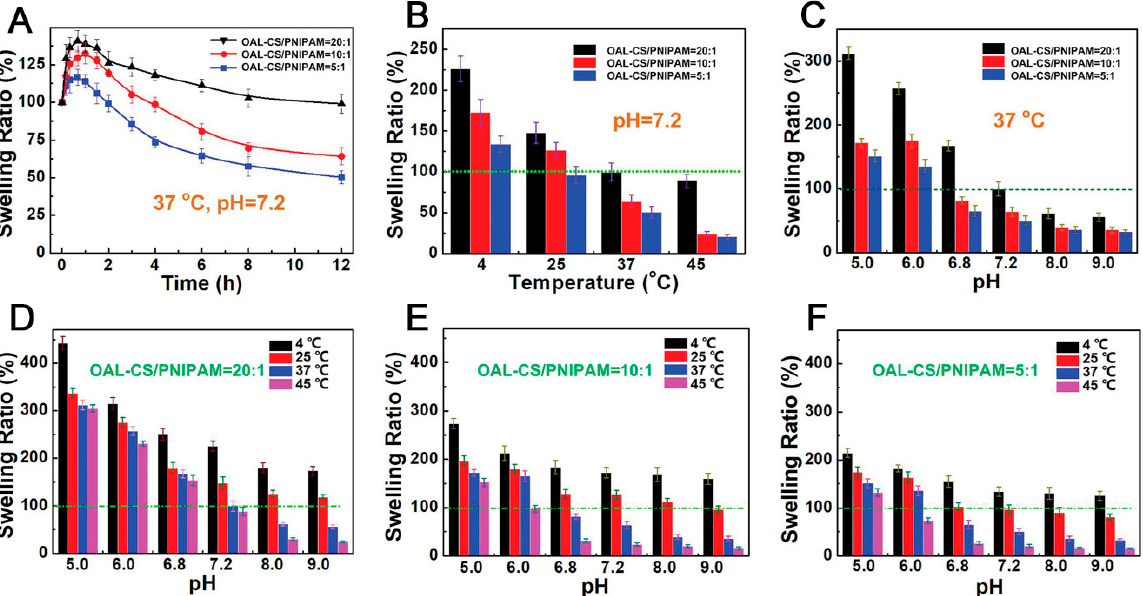
Figure 4. ( A ) Swelling ratios of different OAL-CS/PNIPAM hydrogels at pH 7.2 and 37 ◦ C. ( B ) Swelling ratios of different OAL-CS/PNIPAM hydrogels in pH 7.2 PBS at different temperatures. ( C ) Swelling ratios of different hydrogels at different pH values at 37 ◦ C. ( D ) Changes in swelling ratio in OAL-CS/PNIPAM = 20:1 hydrogel via the effect of temperature and pH. ( E ) Changes in swelling ratio in OAL-CS/PNIPAM = 10:1 hydrogel via the impact of temperature and pH. ( F ) Changes in swelling ratio in OAL-CS/PNIPAM = 5:1 hydrogel via the effect of temperature and pH. Reprinted with permission from [83].